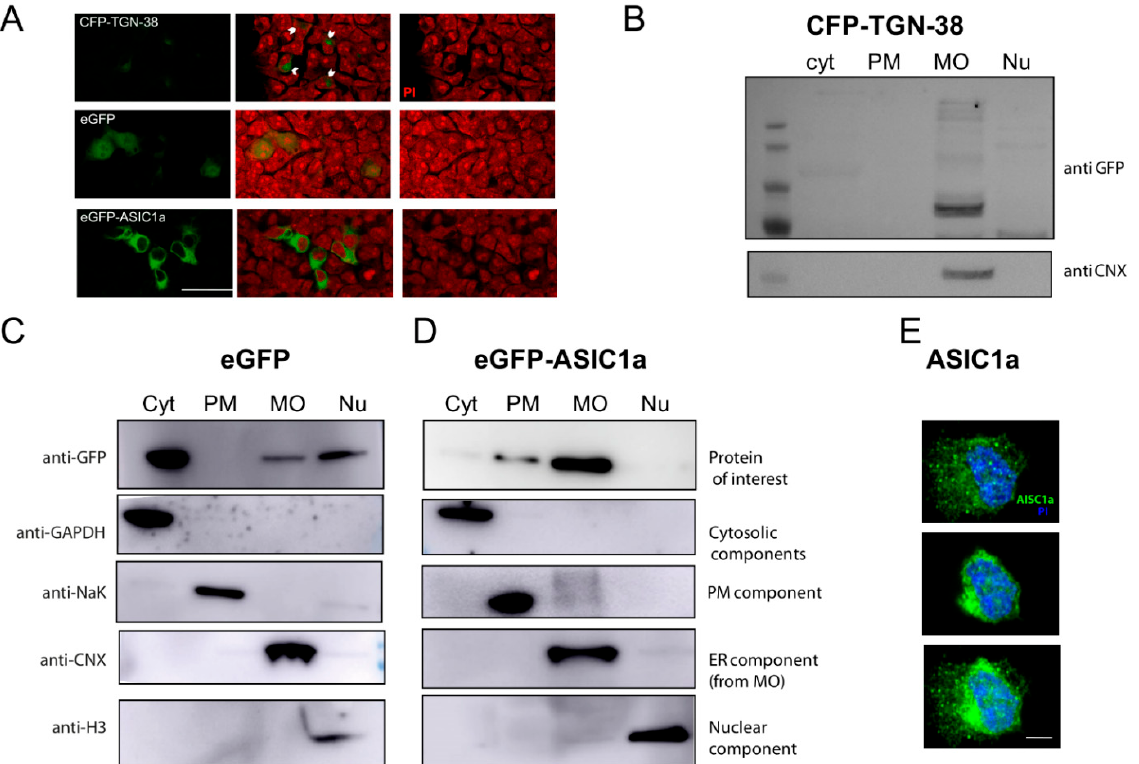
Figure 3. Validation of fractionation method with exogenously expressed proteins. ( A ). Representative immunofluorescence images of HEK cells expressing CFP-TGN-38 (top panels; arrows pointing at areas of cells with eGFP signal), eGFP (middle panels), and eGFP-ASIC1a (lower panels). Signal in green accounted for the fusion protein detected (left panels); PI (Propidium iodide) in red for nuclei (right panels); merge images (middle panel). Scale bar 10 um. ( B ) CFP-TGN-38-expressing cells were subjected to the fractionation protocol, and the lysates for each fraction were analyzed by Western blot experiments. As visualized in a representative membrane, the protein was enriched in the MO fraction (detected with an anti-GFP antibody), as expected, together with a marker for ER (using the anti-calnexin antibody). ( C ) eGFP-expressing cells were subjected to the fractionation protocol, and the lysates for each fraction were analyzed by Western blot experiments. As visualized in a representative membrane, the protein was enriched in the cytosolic, MO, and nuclear fractions, as expected. Each one of the fractions was confirmed to be enriched in proteins known to be abundant (GAPDH for Cyt; NaK for PM; CNX for MO (from the ER); and H3 for Nu). ( D ) eGFP-ASIC1a-expressing cells were subjected to the fractionation protocol, and the lysates for each fraction were analyzed by Western blot experiments. As visualized in a representative membrane, the protein was enriched in the PM and MO fractions. ( E ) Representative confocal microscopy images of HEK293 cells stained with an anti-ASIC1 antibody (and secondary Alexa-488, green), and with PI to visualize nuclei, showing a superficial section (top), a middle section (middle), and a merge of layers (bottom). Notice a predominant perinuclear staining. Scale bar 5 µ